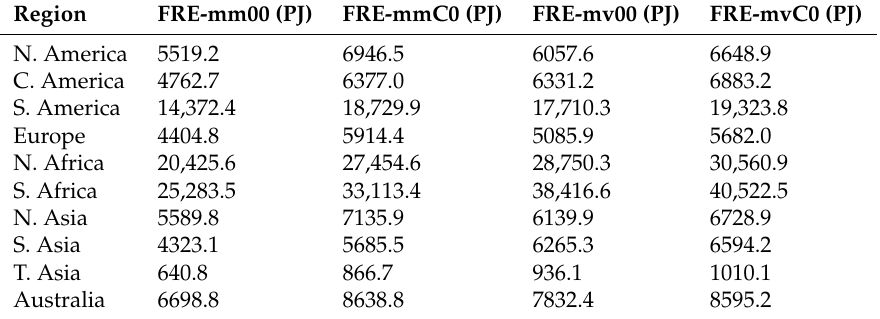
Table 3. The annual Fire Radiative Energy (FRE) of 2017 (in PJ) from all four experiments (Table 1) for all regions. Abbreviations mv00: Uncorrected gridded-FRP from MODIS/Terra and VIIRS/Suomi-NPP are used as input. VIIRS/Suomi-NPP is used as a replacement for MODIS/Aqua. mmC0: Corrected gridded-FRP from both MODIS/Aqua and MODIS/Terra are used as input. mvC0: